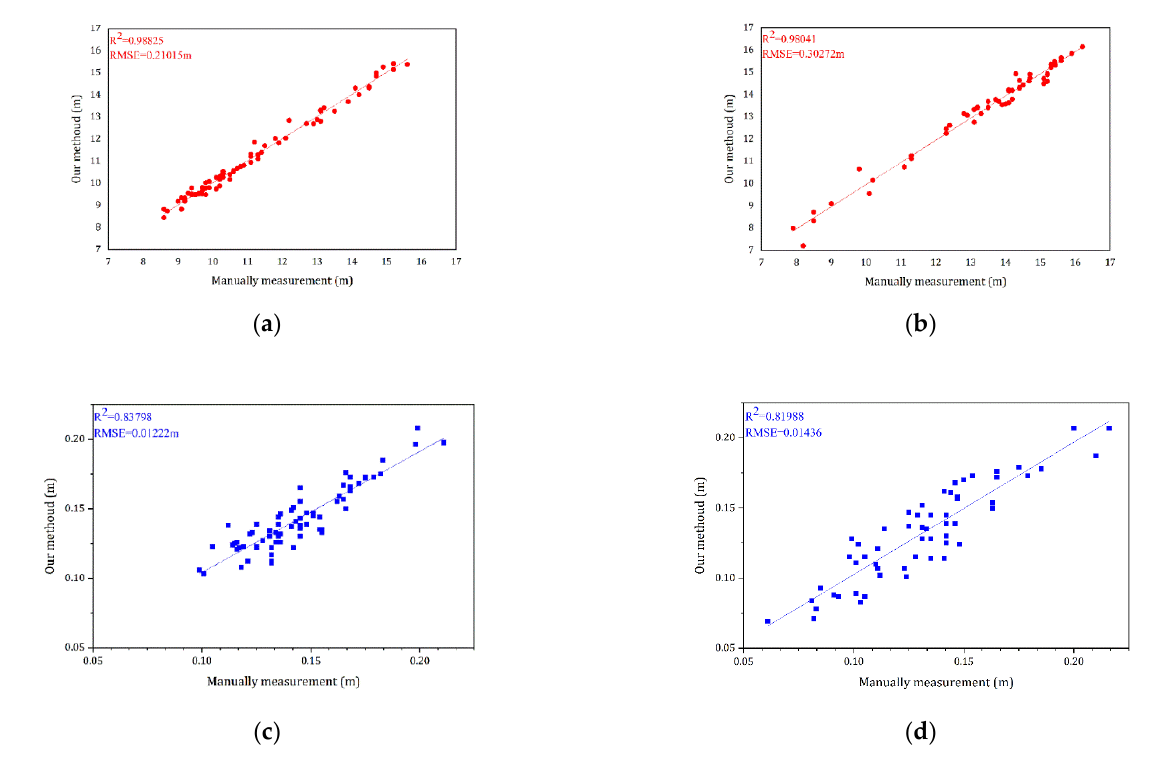
Figure 12. ( a , c ) Comparison of tree height and diameter at breast height with manual measurements for the Bajia test set. ( b , d ) Comparison of tree height and diameter at breast height with manual measurements for the Gaotang test set.